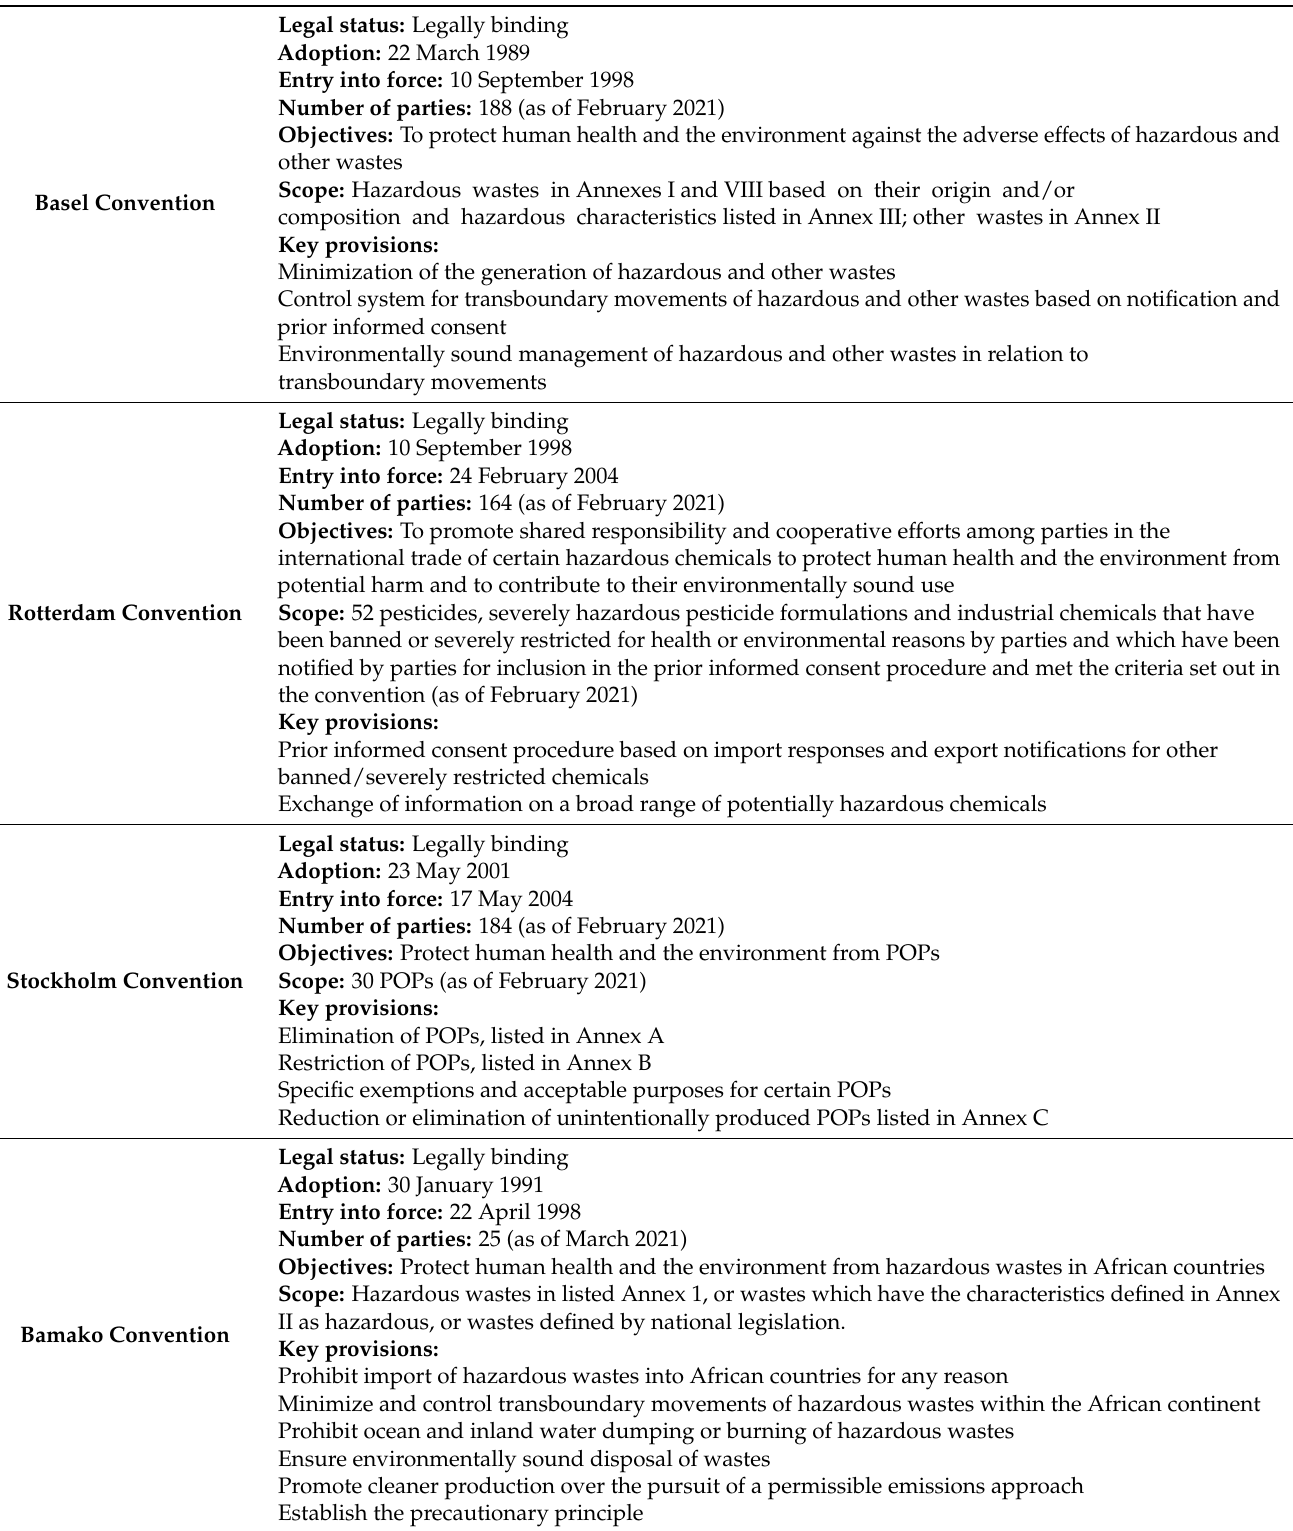
Table 3. The Basel, Rotterdam, Stockholm, and Bamako Conventions on hazardous